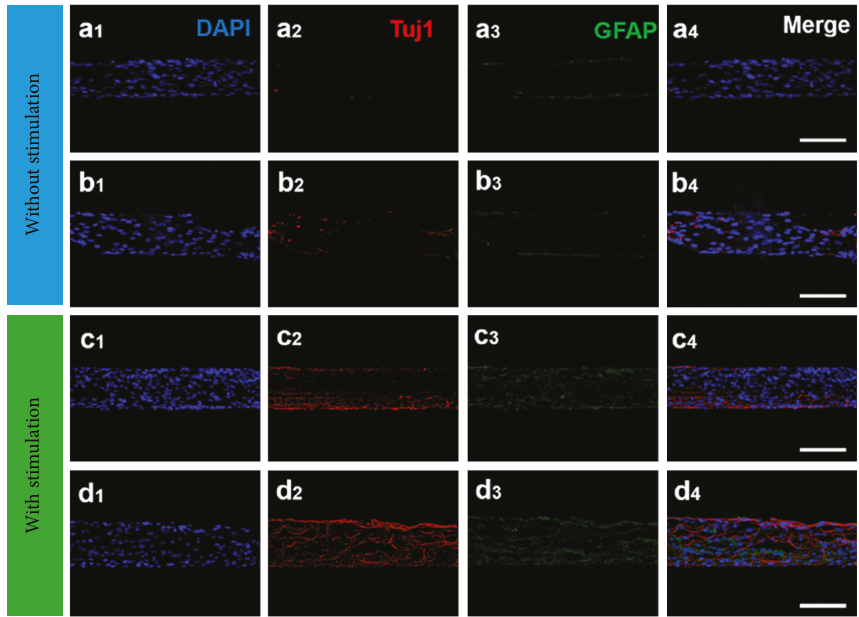
Figure 7: Cells were immunostained with (1) DAPI (blue) for the nucleus and neural-speci fi c antibodies (2) Tuj1 (red, cy3) and (3) GFAP (green, FITC) after being cultured under stimulation culturing conditions without TENG electrical stimulation (a, b) or with human- motion-driven TENG electrical stimulation (c, d) for 21 days on an rGO micro fi ber (a, c) and 15% rGO-PEDOT hybrid micro fi ber (b, d). (Right) Merged fl uorescence images (scale bar = 100 μ m )